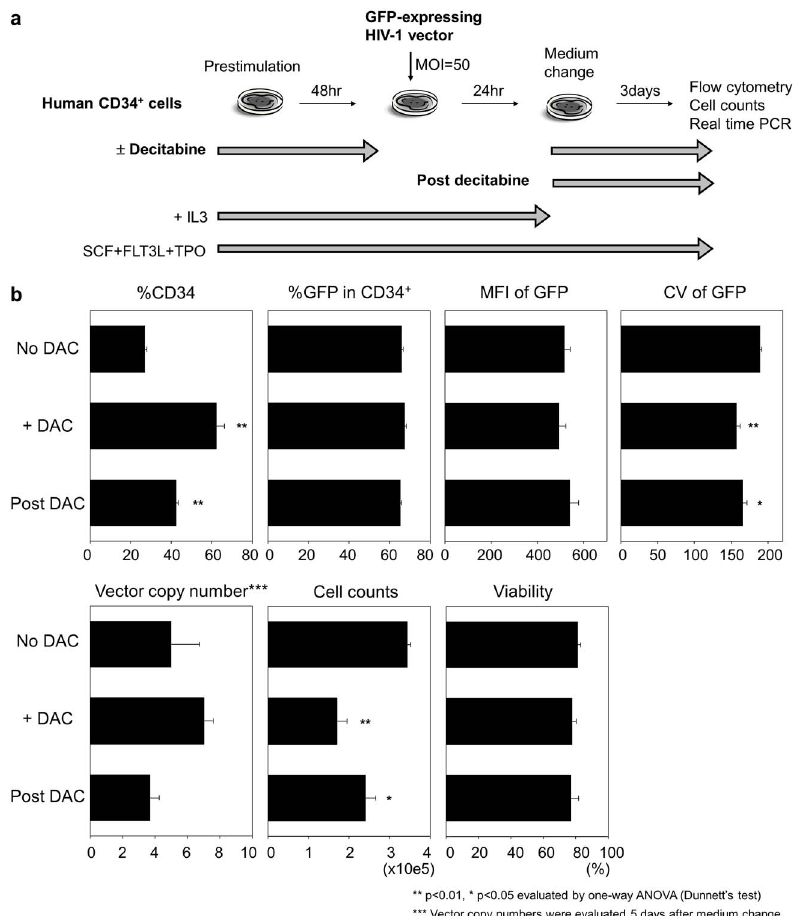
Figure 4. Post-transduction decitabine exposure reduced variability of GFP intensity in transduced CD34 + cells. (a). To evaluate whether decitabine exposure affects internal promoter activity in lentiviral vectors to drive GFP expression, human CD34 + cells were exposed to decitabine (0.5 m M) following lentiviral transduction (Post DAC) with 48-hour prestimulation (SCF, FLT3L, TPO, and IL3), and we analyzed GFP expression by flow cytometry and average vector copy number per cell by real time polymerase chain reaction (PCR). (b). Post-transduction decitabine exposure resulted in equivalent %GFP, GFP intensity, and vector copy number, while lower CV of GFP intensity was observed in post- transduction decitabine exposure, compared to no decitabine exposure. The similar decitabine effects were detected when CD34 + cells were exposed to decitabine before and after transduction. In addition, higher %CD34, lower cell counts, and equivalent viability were observed in both decitabine exposure groups. We tested statistical significance of data in all decitabine exposure groups, compared to no decitabine